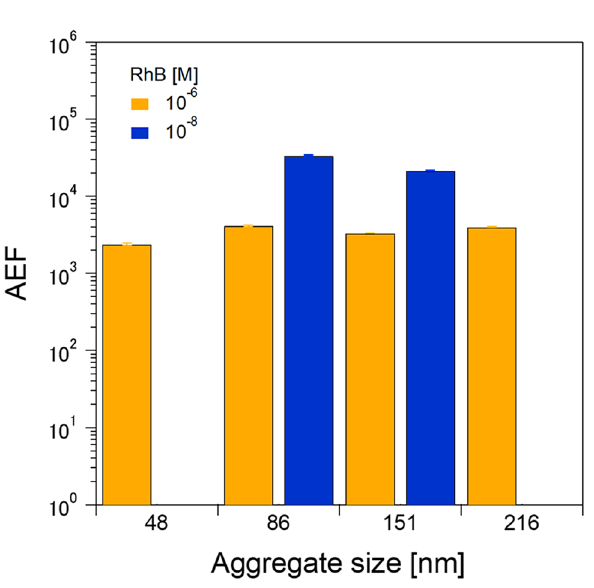
Figure 5. AEF values at 10 –6 and 10 –8 M RhB concentrations for the AgNP aggregate sizes of 48, 86, 151 nm, and 218 nm. No AEF values were calculated the 48- and 218-nm aggregate at the 10 –8 M RhB concentrations because of the absence of RhB peaks.